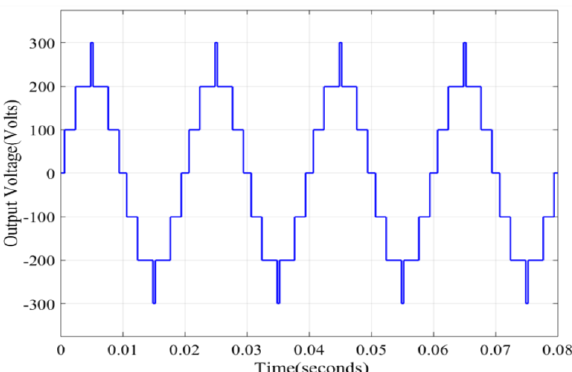
Figure 14. Outpu t of the Quasi− linear MLI implemented with an inductively dominated RL Load. Figure 14. Output of the Quasi-linear MLI implemented with an inductively dominated RL